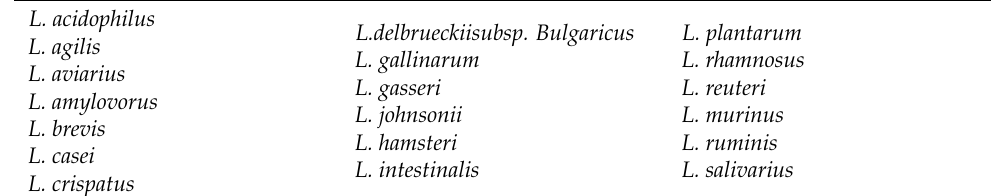
Table 3. Lactobacillus Species Detected in the Intestinal Tract and/or used in Probiotic Products. L.